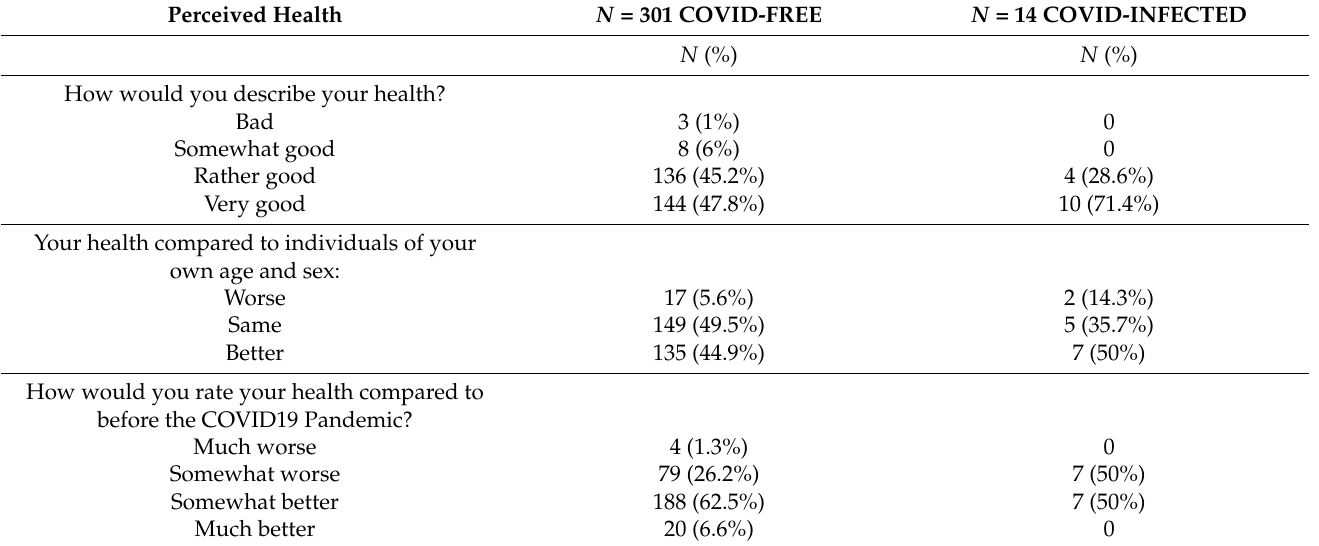
Table 2. Perceived health compared to that before the pandemic.